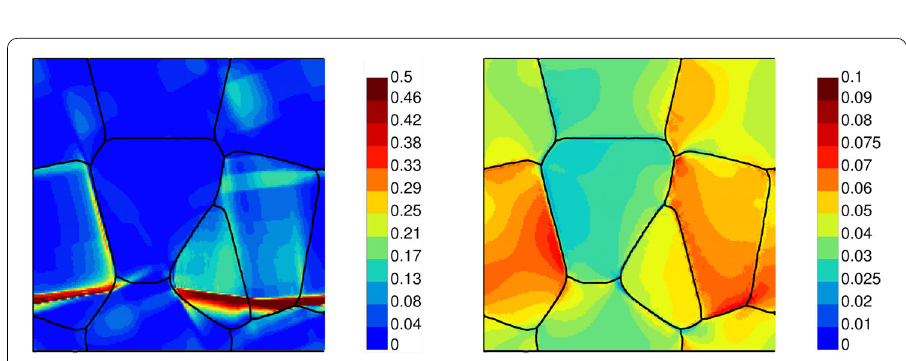
Fig. 7 The non-dimensionalized stored energy ψ ρ / f 0 with one (left) or four (right) active slip systems. The scale for the left-hand image has been cut-off at 0.5 in order to more clearly show how the stored energy is distributed in the different grains. The true maximum value is around ψ ρ / f 0 = 0 . 9. The scale for the right-hand side image has not been